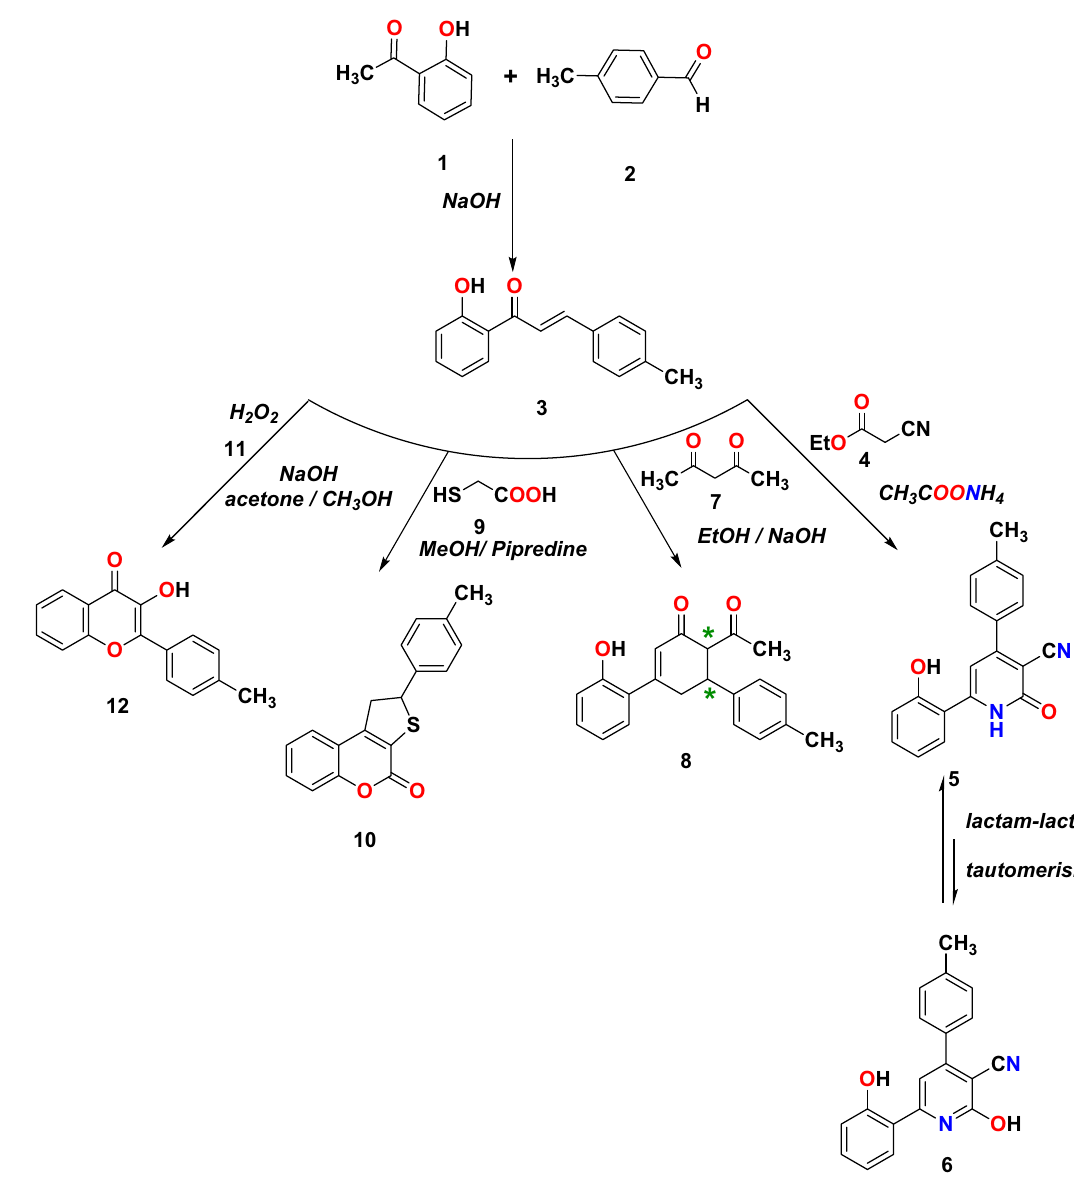
Figure 3. Synthesis of different heterocylic